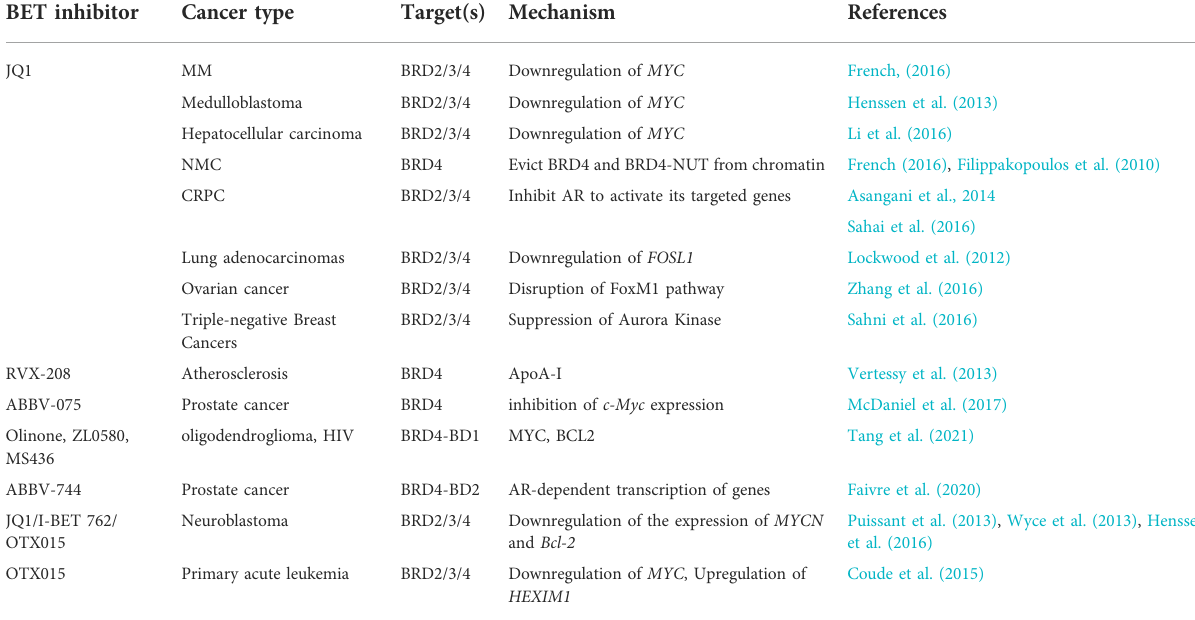
TABLE 1 BET inhibitors are used in multiple cancer